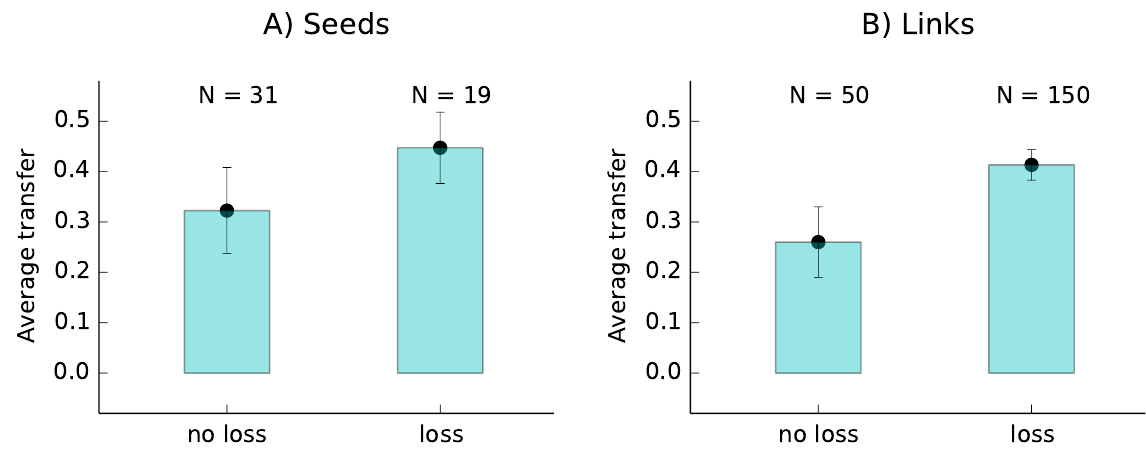
Figure 1: The effect of generalized reciprocity on the amount transferred from the next participant. The figure shows the mean transfer rate and 95% confidence interval for A) seeds and B) links in the no- observation condition, along with the number of observations in each condition. The figure shows higher transfer rates among those who have experienced a loss but the differences are statistically significant only among links, whose loss was imposed by the actions of another